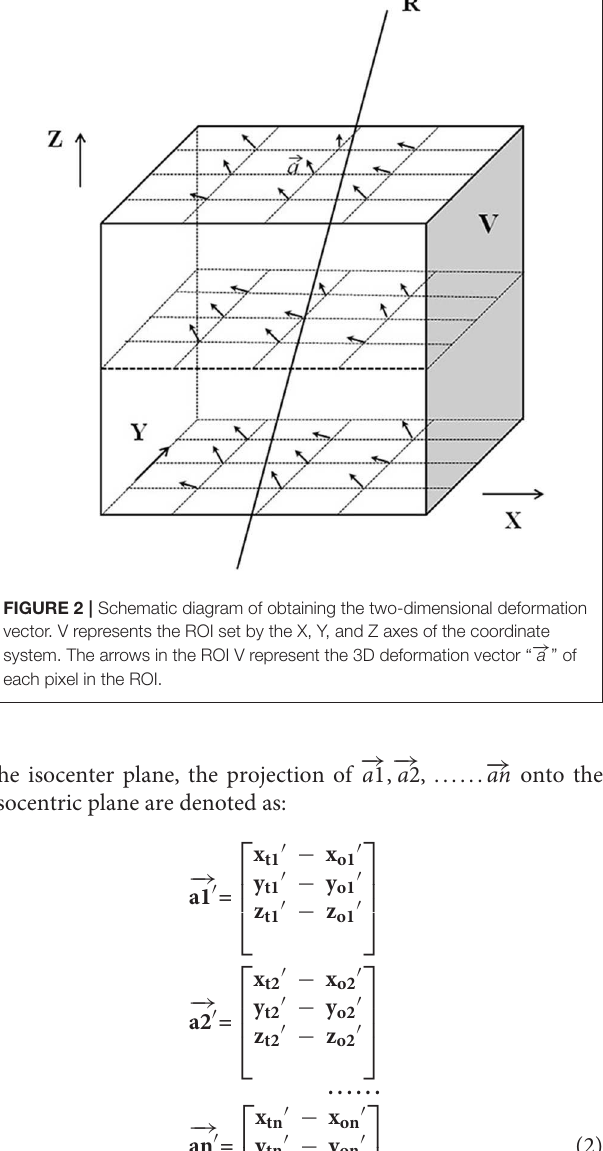
the isocenter plane, the projection of